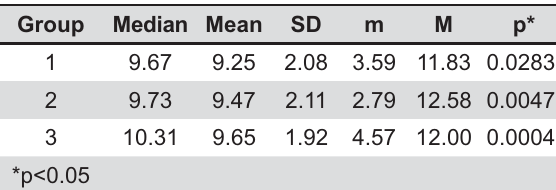
Figure 3- Points C1 and Table 1- Descriptive measurements and test of normality for method error (Shapiro-Wilks)